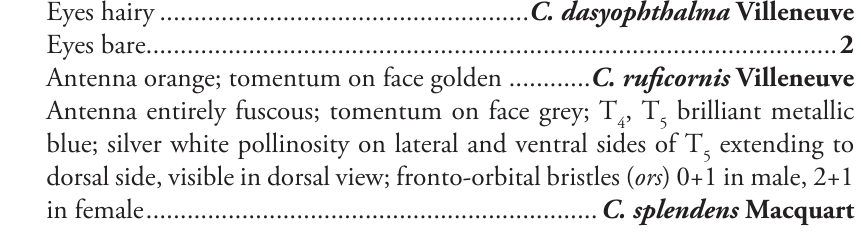
Antenna entirely fuscous; tomentum on face grey; T blue; silver white pollinosity on lateral and ventral sides of T dorsal side, visible in dorsal view; fronto-orbital bristles ( ors ) 0+1 in male, 2+1